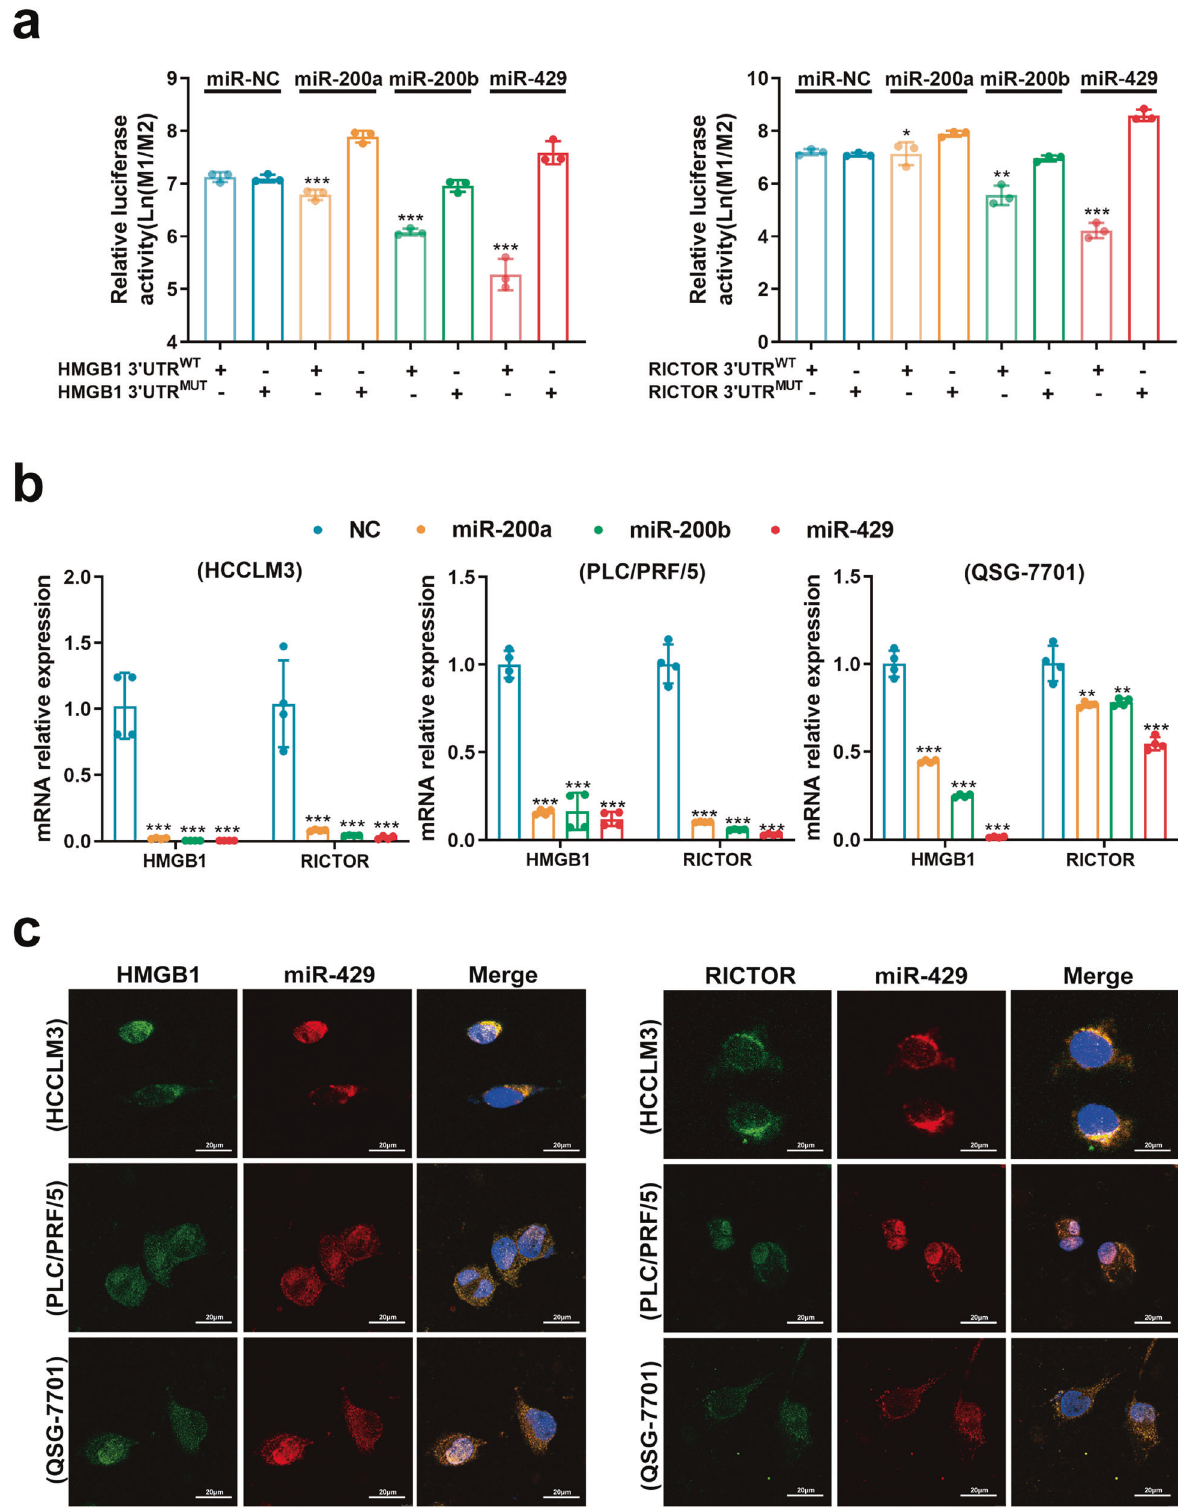
Fig. 3 miR-200 family mediates the “ RNA – RNA ” crosstalk between HMGB1 and RICTOR. a Luciferase assays with reporter constructs containing the wild-type or mutant HMGB1/RICTOR 3 ′ UTR downstream of the luciferase gene were performed after co-transfection with miR- 200a/200b/429 mimics in HEK293T cells. * p < 0.05, ** p < 0.01, *** p < 0.001. b The mRNA levels of HMGB1 and RICTOR were determined by qRT- PCR 48 h after transfection of 100 nM miR-200a/200b/429 mimics in indicated cells. ** p < 0.01, *** p < 0.001. c RNA FISH assays detecting the cellular localization of HMGB1/RICTOR and miR-429 in indicated